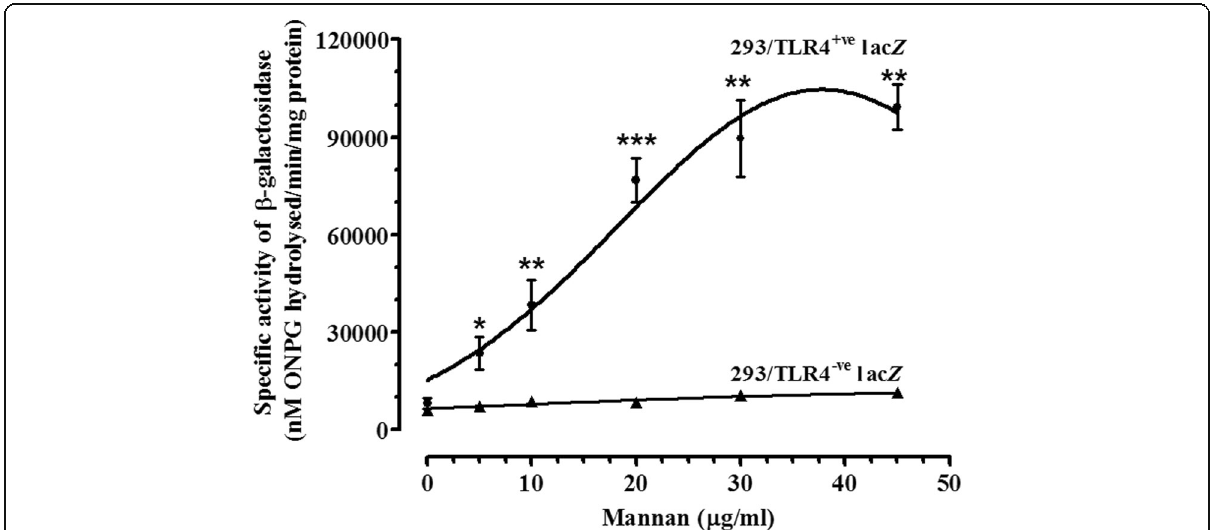
Fig. 1 NF- κ B Reporter gene assay. Cells were treated with increasing concentration (0 – 45 μ g/ml) of Mannan for 6 h at 37 °C to check the activation of NF κ B in terms of specific activity of β -galactosidase as described under materials and methods. Results are expressed as nM of ONPG hydrolysed/min/mg protein ± SD of three independent experiments. Differences with respect to untreated controls were designated significant at values * p < 0.05, ** p < 0.001 and *** p <